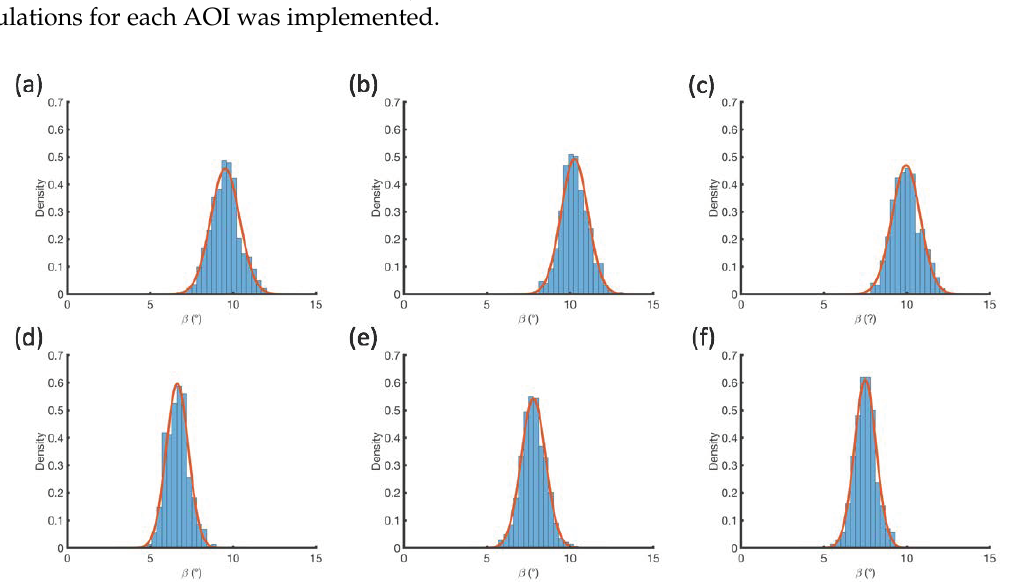
Figure 2. Normalized β histograms and fitted Gaussian distributions referring to: ( a – c ) UAVSAR scene ID 1 acquired at low (22–27 ◦ ), intermediate (31–35 ◦ ) and high (38–42 ◦ ) AOIs, respectively; and ( d – f ) the same for UAVSAR scene ID